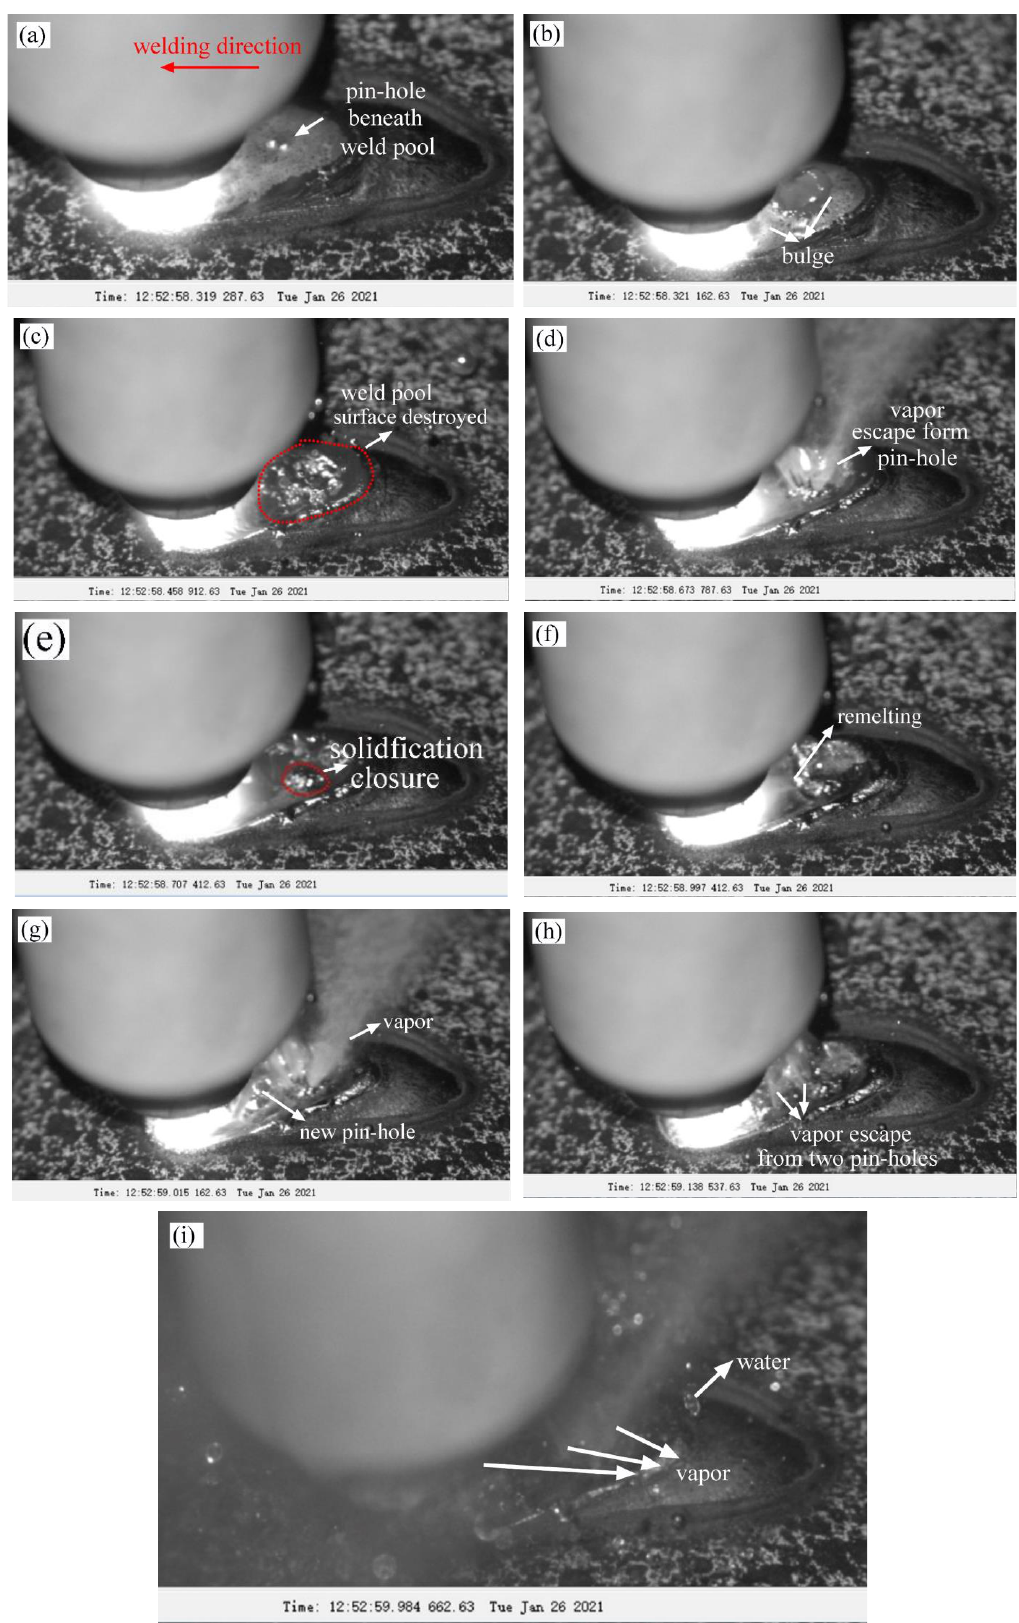
Figure 7. Dynamic evolution behavior during the burn-through process of the 26K-6: ( a ) 0.319 s; ( b ) 0.321 s; ( c ) 0.459 s; ( d ) 0.674 s; ( e ) 0.707 s; ( f ) 0.997 s; ( g ) 1.015 s; ( h ) 1.139 s; ( i ) 1.984 s. Based on the external observation device, the dynamic behavior of the burn-through instability was observed in detail. However, all the phenomena occurred below the molten pool during the external observation, which was a relatively indirect observation. In order to obtain the phenomena on the inner surface of the pipe, the internal visualization device was introduced. As shown in Figure 8a, the welding direction was marked. The direction of water flow has been indicated in the figure. When the welding started, the temperature increased. The water was quickly heated to boiling point and produced a large number of bubbles. The pipe pressure increased by 0.3–0.6 MPa during this process. As shown in Figure 8b, the high-temperature area on the inner surface continued to become larger, and more bubbles were produced. As shown in Figure 8c, a high-temperature overheating area appeared on the inner surface. Then, a burn-through hole was formed in the overheating area, and a large amount of water began to be ejected. Even though the ABB welding robot was used, an overheating area might still be formed, which often developed into the ini- tiation position of burn-through instability.